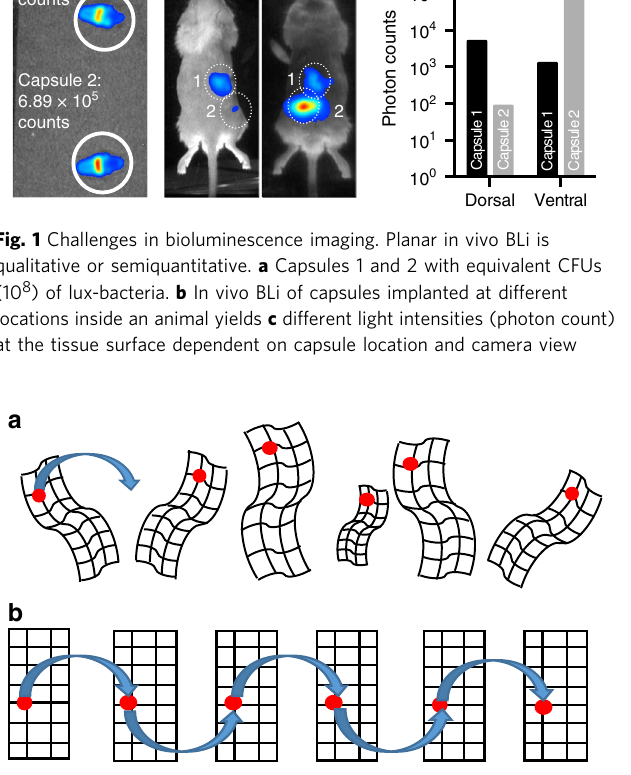
the photon emission density distribution is linearly translated, for example, into a spatial map of colony forming units (CFU) of bacteria by using a known CFU and light emission density obtained from an independent calibration experiment.